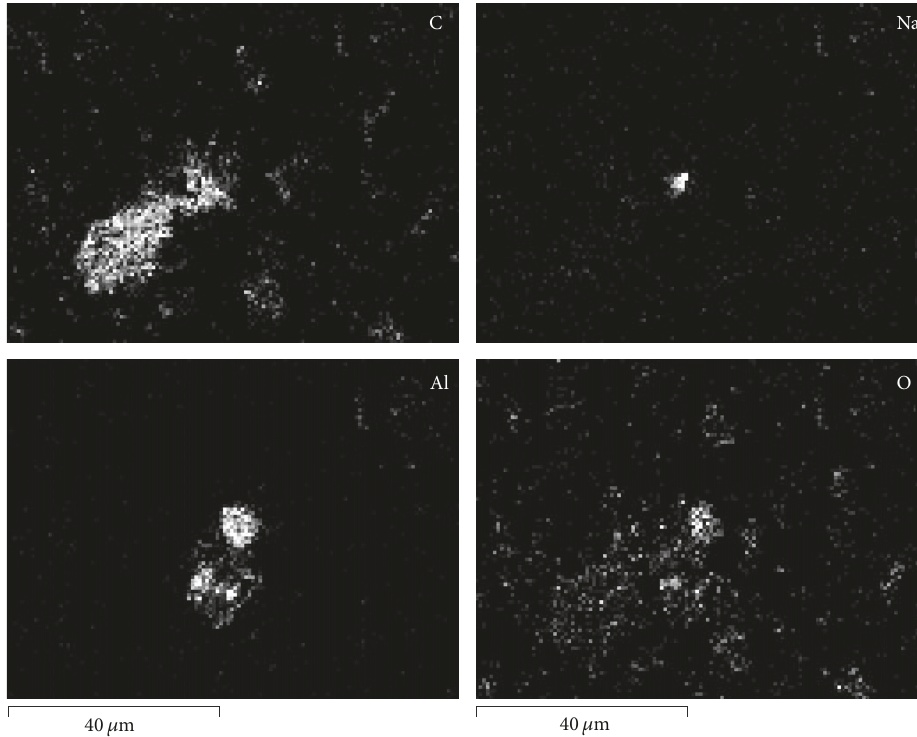
Figure 6: EDS maps for the right breakdown site in Figure